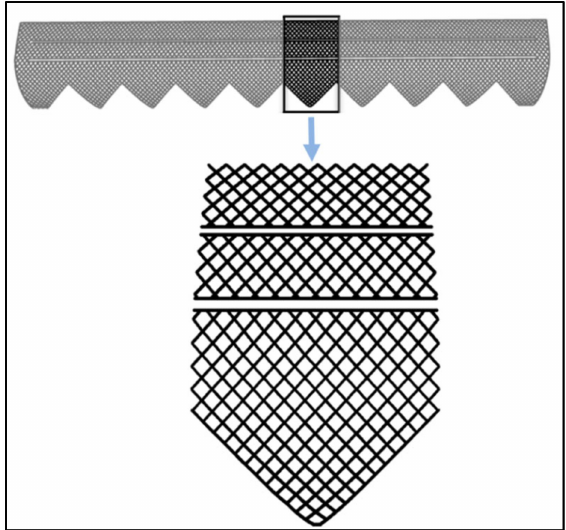
Figure 6. Exhibition Center Phase II optimization